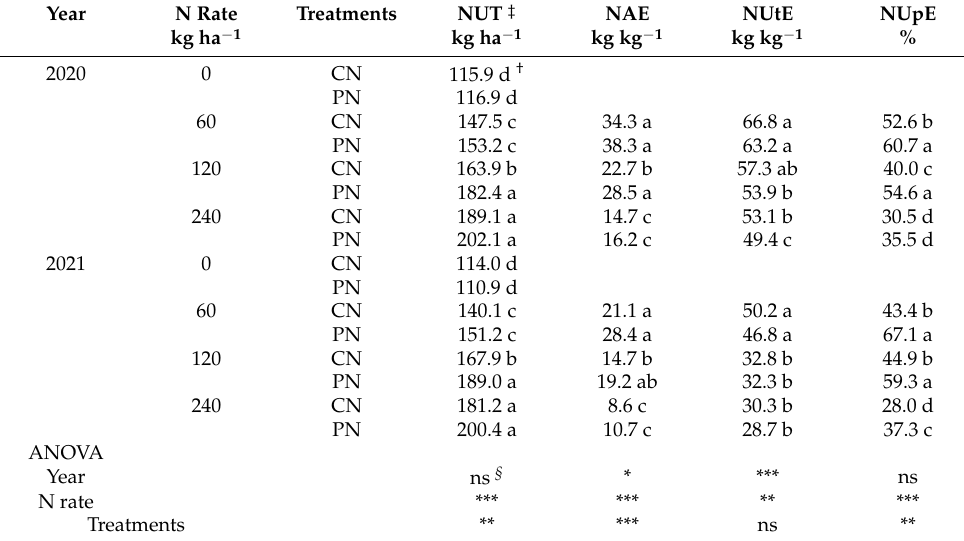
Table 2. Sorghum total nitrogen uptake (NUT), N agronomic efficiency (NAE), N utilization efficiency (NUtE) and N uptake efficiency (NUpE) at 0–240 kg ha − 1 nitrogen fertilizer rates under control treatment (CN) and polyaspartic acid-coated urea (PN) in 2020 and 2021. Year N Rate Treatments NUT ‡ NAE